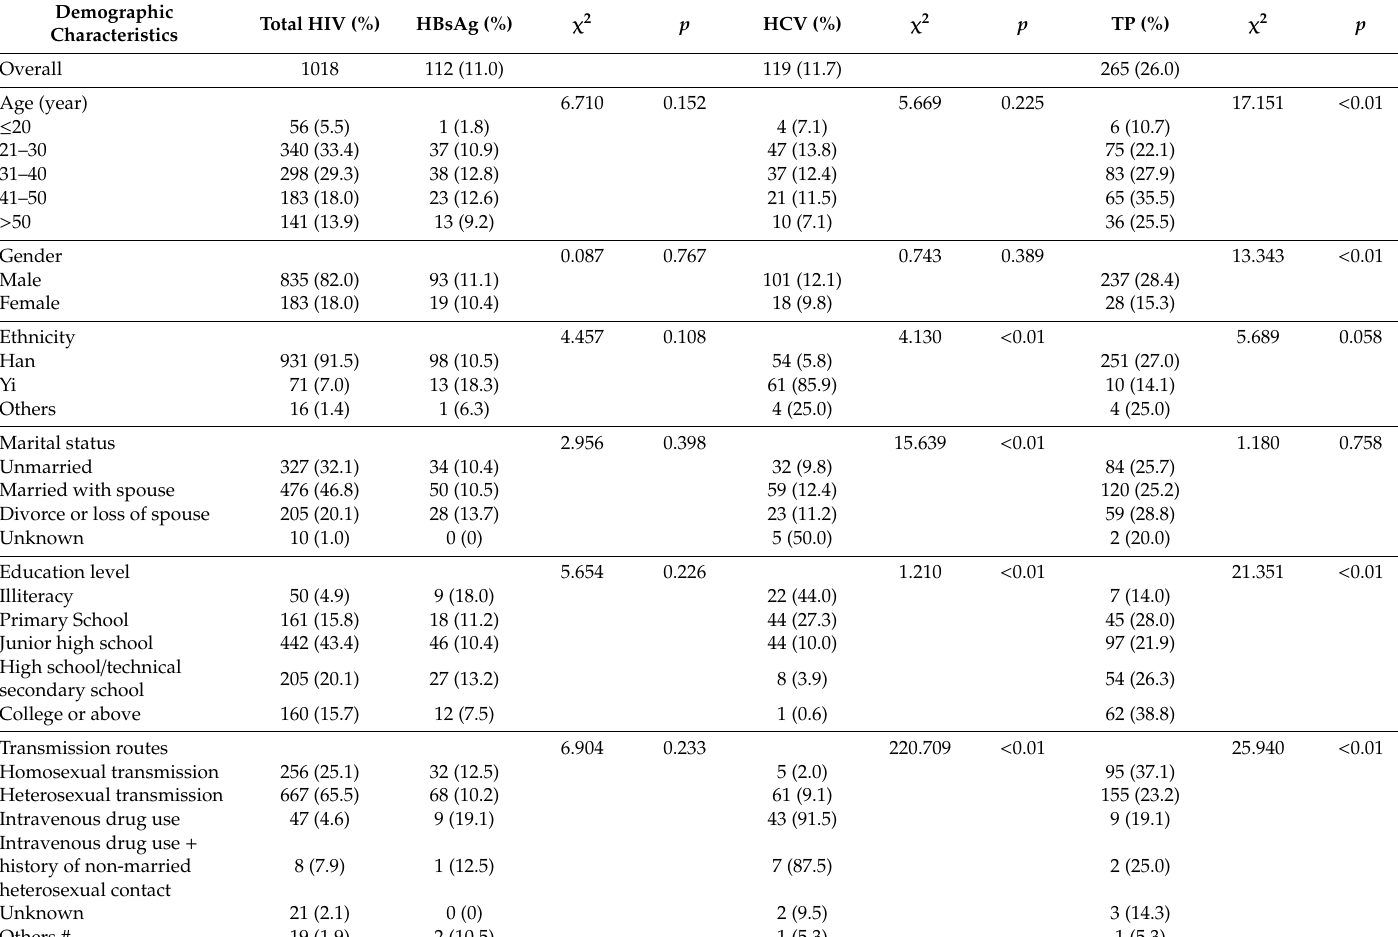
Table 2. Characteristics of HBV, HCV, TP in 1018 HIV-infected patients in Shaanxi Province. Demographic